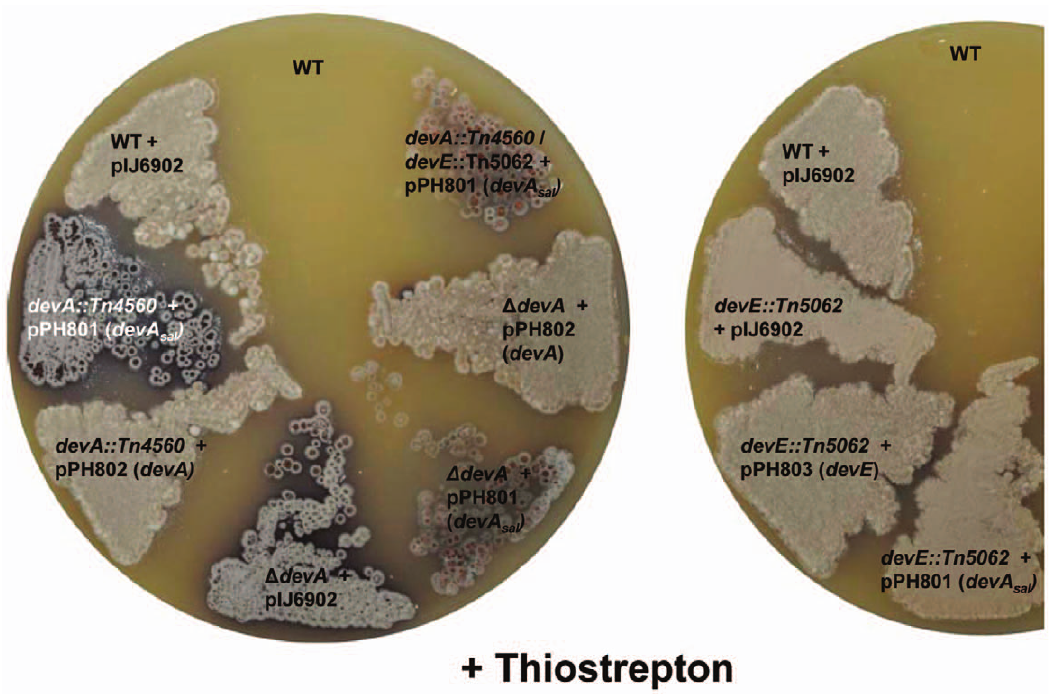
Figure 5. Effect of complementation of devA and devE disruptions with devA from Salinisporatropica , under the control of the thiostrepton inducible promoter ( tipA ), on colony appearance. Strains were grown on MS medium for 5 days in the presence of thiostrepton.